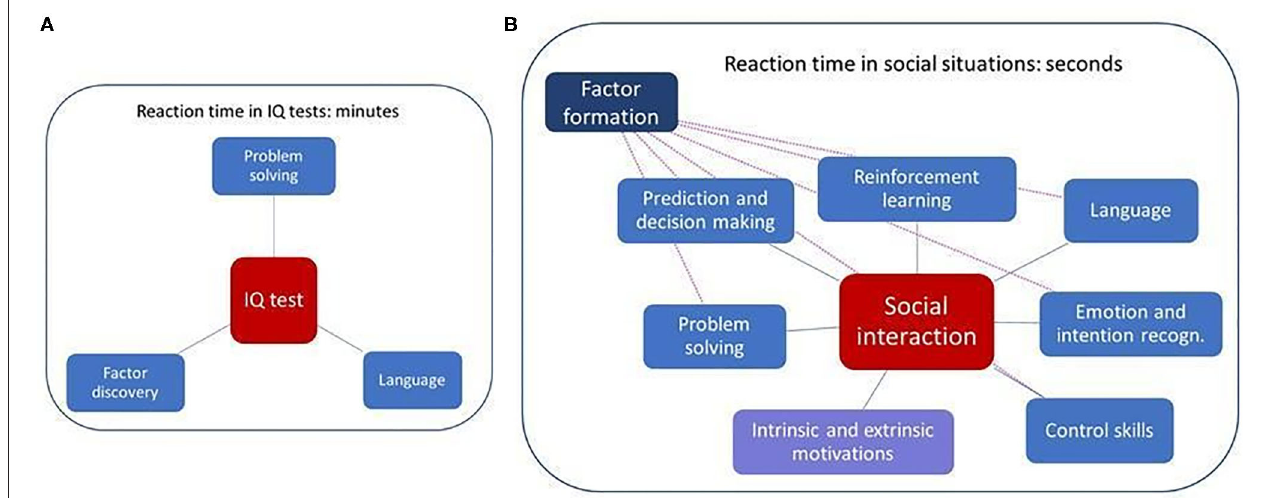
FIGURE 8 | Time constraints and components needed for solving (A) IQ tests and (B) goal-oriented tasks in social interactions. Solid lines: main components, dashed lines: dependencies from the point of view of factor formation. Components of typical IQ tests are limited to Type 1 Cartesian Factors (CF1), including e.g., matrix tasks like in Figure 1H , or pattern completion task related to language. The number of components of social interactions is much larger and concerns both CF1s and CF2, involving a much larger search space of problem solving. Temporal constraints differ, too; time for an IQ test is prescribed and is on the scale of minutes, whereas social interaction may be much shorter (ms domain), but can be considerably longer as well. Differences are (a) in the complexity of the two problem types and (b) in their static (IQ) vs. dynamic (social) nature,